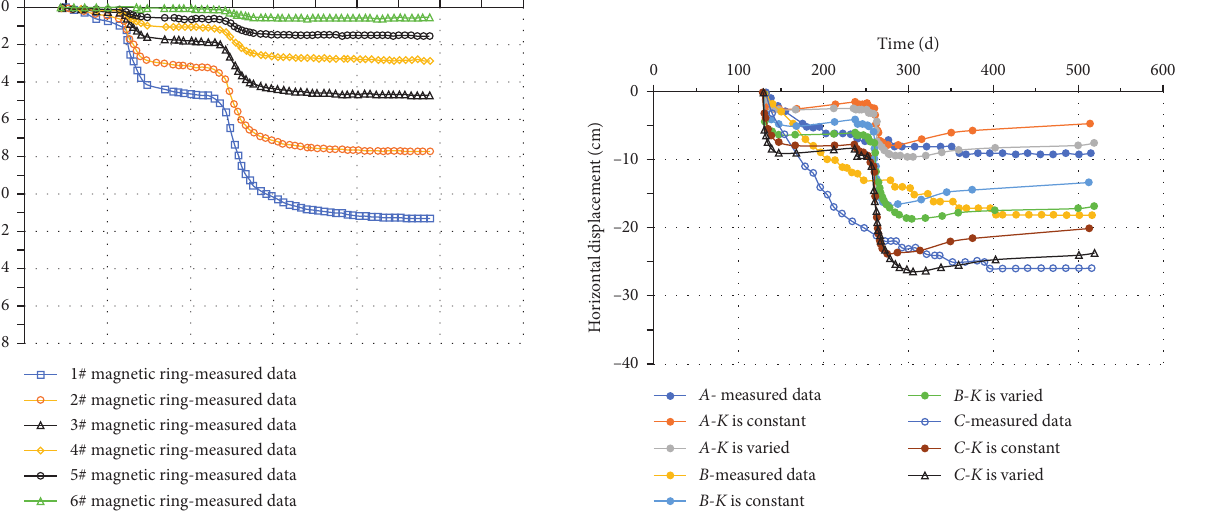
Figure 8: Time-history change curve of the layered settlement monitoring value.